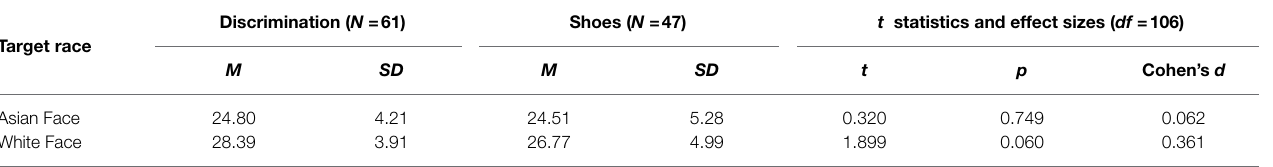
TABLE 1 | Means and standard deviations of emotion accuracy scores. Discrimination ( N = 61) Shoes ( N = 47) t statistics and effect sizes ( df = Target race